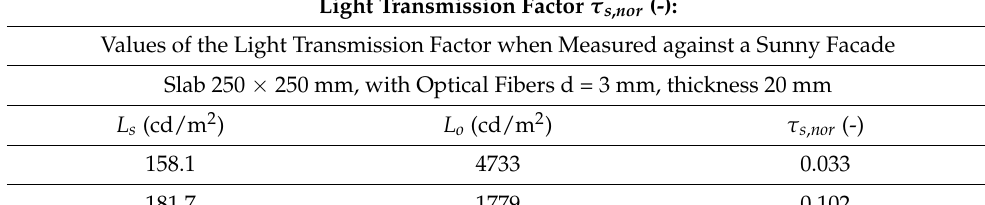
Values of the light transmission factor when measured against a non-sunlit facade